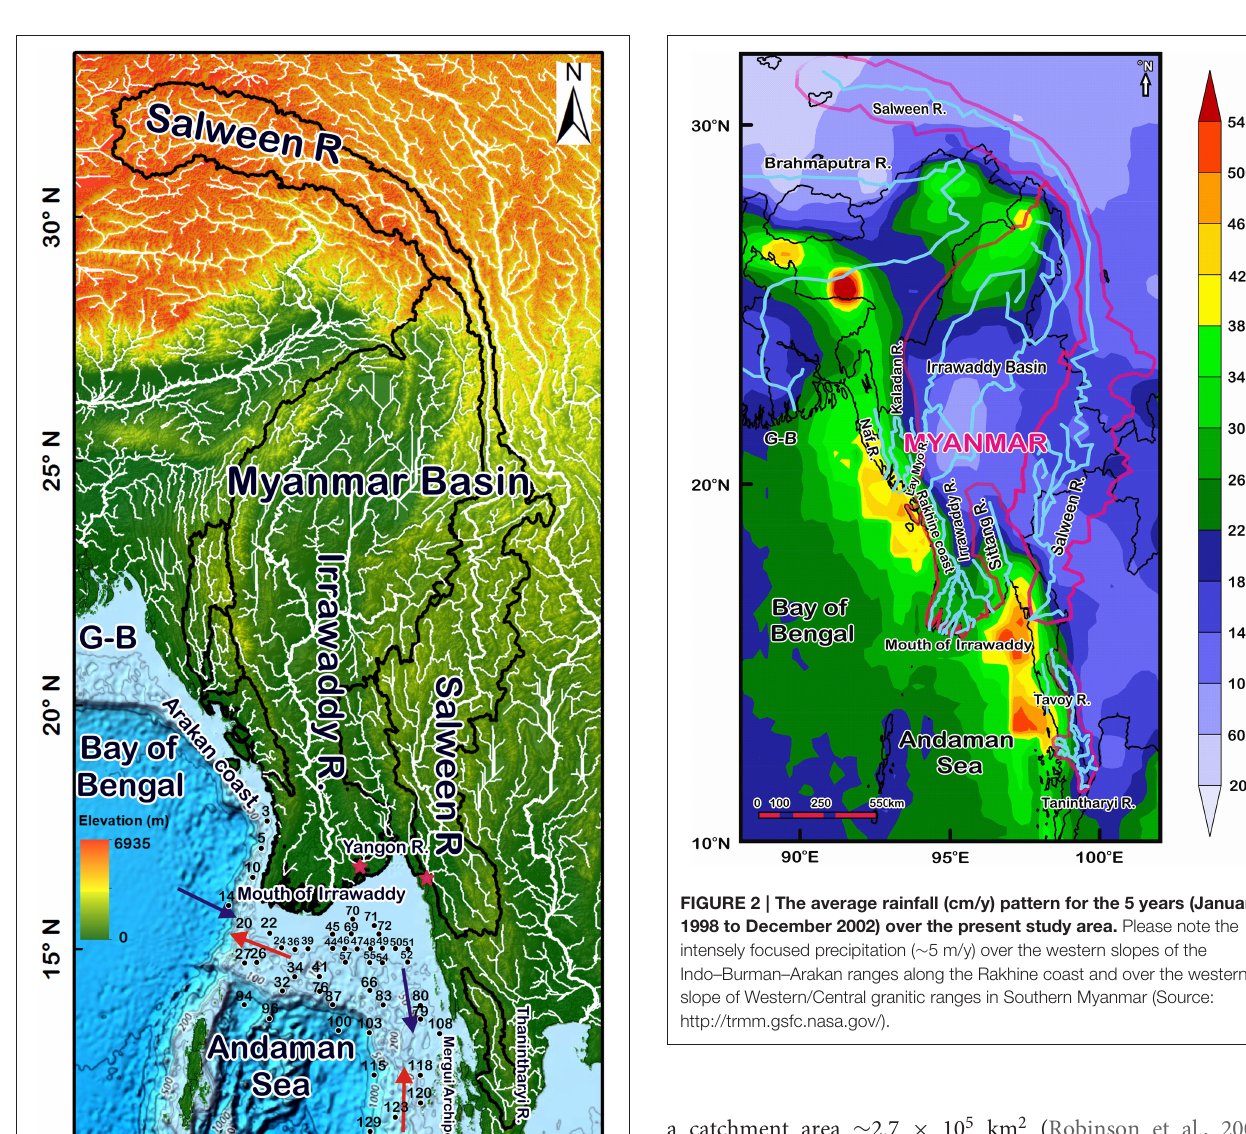
a catchment area ∼ 2.7 × 10 5 km 2 (Robinson et al.,